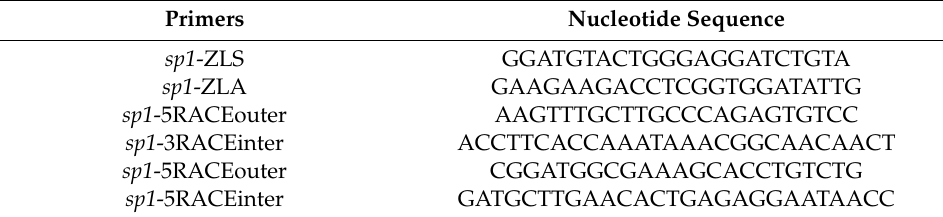
Table 3. Primers for cloning sp1 in this